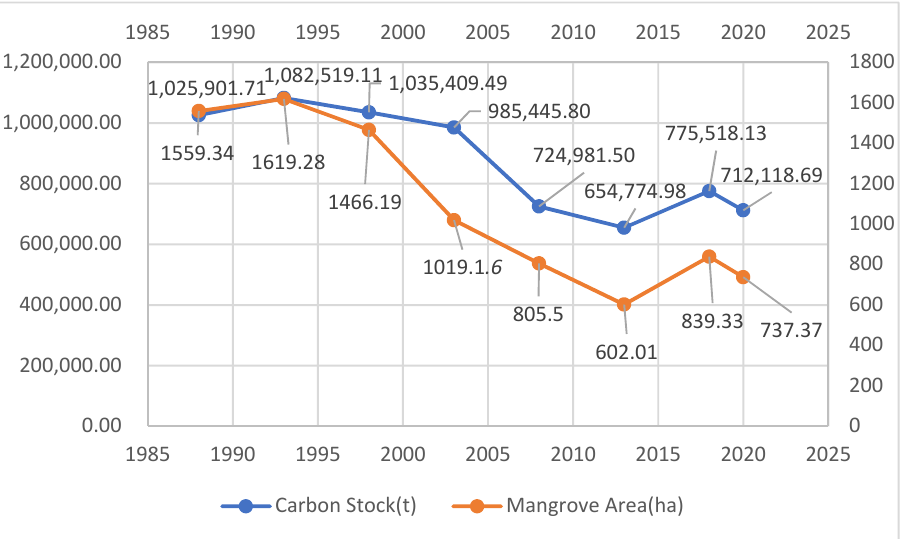
Figure 5. Total carbon stock changes with the mangrove cover change in Qinglan Port from 1988 to 2020 (ton).